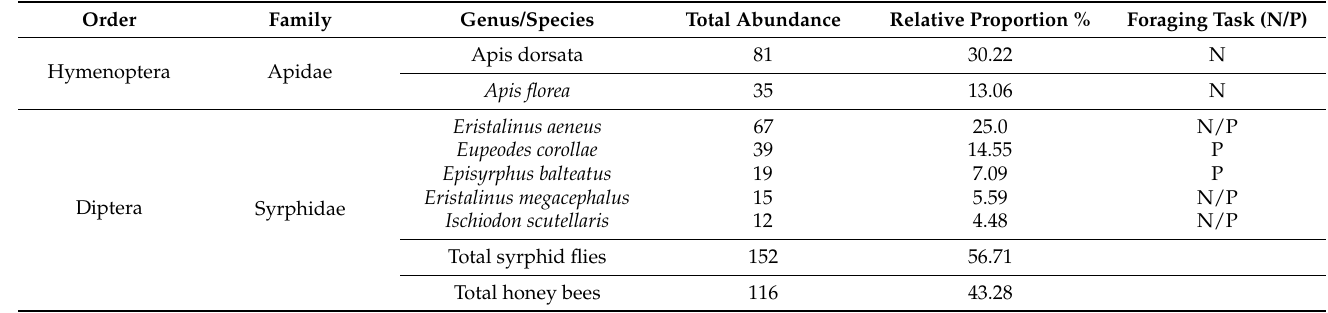
Table 1. Insect species feeding on strawberry flowers, with their total abundance, relative proportion, and foraging task in a strawberry field at Multan, Pakistan, from February to April,